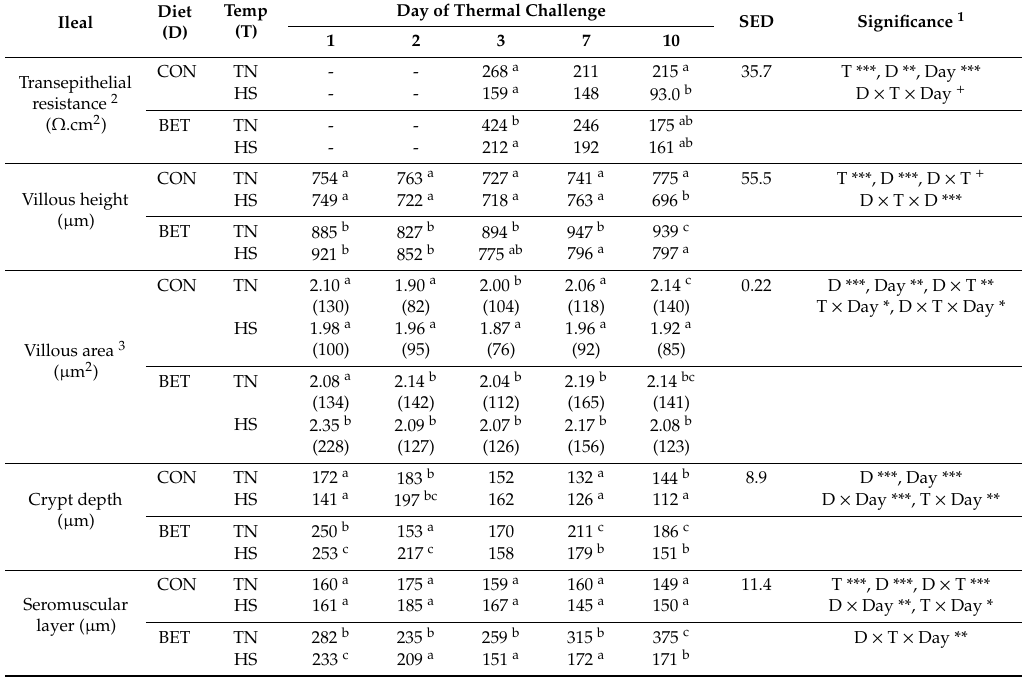
Table 2. E ff ects of a control diet (CON) or dietary betaine (BET) on ileal transepithelial electrical resistance and ileal morphology in broilers under thermoneutral (TN) or heat stress (HS) conditions for 1, 2, 3, 7 and 10 days.